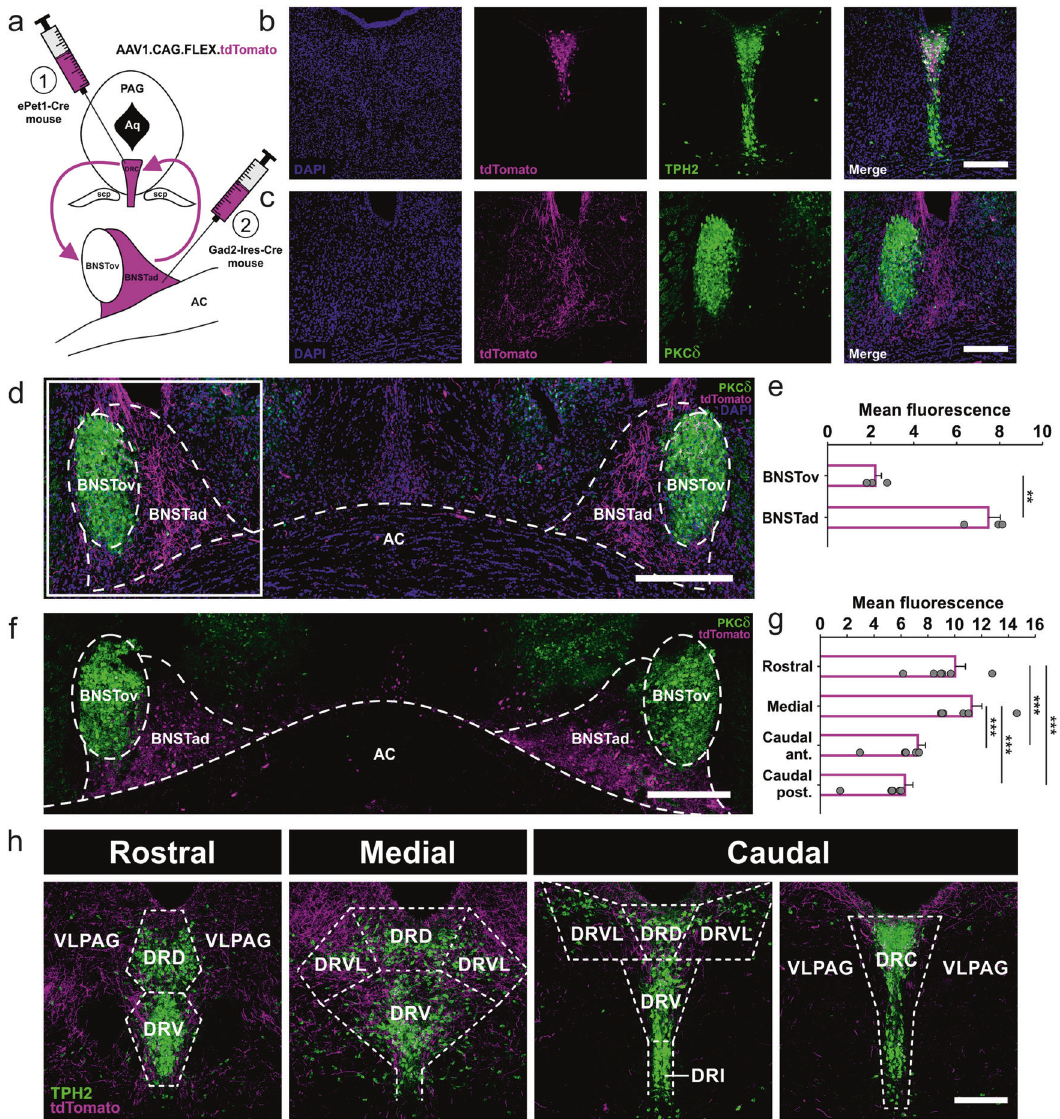
Fig. 4 The DRN and the dorsal BNST are reciprocally connected. a AAV-based labeling strategy of anterograde terminals. AAV1.CAG.FLEX.tdTomato virus was injected either into the DRC of ePet1-Cre mice (1) to label 5-HT terminals innervating the BNST, or into the BNSTad subregion of Gad2-Ires-Cre mice (2) to label GABAergic terminals innervating the DRN. b DRC injection site in an ePet1-Cre mouse indicates selective tdTomato expression (magenta) in TPH2 + 5-HT cells (green). Scale bar = 200 µm. c BNST target site in an ePet1-Cre mouse showing tdTomato + 5-HT terminals (magenta) arising from the DRC. PKC δ (green) was used as a marker for the BNSTov subregion. Scale bar = 200 µm. d Overview of the dorsal BNST in an ePet1-Cre mouse re fl ecting the bilateral innervation of the BNSTad with tdTomato + 5-HT terminals (magenta) arising from the DRC. PKC δ (green) was used as a marker for the BNSTov subregion. Boxed region is separately shown in c . Scale bar = 300 µm. e Quanti fi cation of tdTomato fl uorescence intensity in the dorsal BNST. tdTomato + 5-HT terminals innervate primarily the BNSTad subregion. Two-tailed Student ’ s paired t-test (BNSTov vs. BNSTad): P = 0.007. Injected mice ( n = 3). Data are shown as means ± SEM. ** P < 0.01. f Overview of bilateral BNSTad injection sites in a Gad2-Ires-Cre mouse. tdTomato + GABAergic cells (magenta). PKC δ (green) was used as a marker for the BNSTov subregion. Scale bar = 300 µm. g Quanti fi cation of tdTomato fl uorescence intensity in the DRN. tdTomato + GABAergic terminals arising from the BNSTad innervate all rostrocauldal DRN levels. Rostral and medial level show the strongest innervation. One-way RM ANOVA ( fl uorescence): F (3,15) = 34 . 018, P ≤ 0,001; pairwise Holm – Sidak test: rostral vs. caudal anterior: P ≤ 0.001, rostral vs. caudal posterior: P ≤ 0.001, medial vs. caudal anterior: P ≤ 0.001, medial vs. caudal posterior: P ≤ 0.001. Injected mice ( n = 6). Data are shown as means ± SEM. *** P < 0.001. h DRN target site in a Gad2-Ires-Cre mouse showing tdTomato + GABAergic terminals (magenta) arising from the BNSTad. The pattern of TPH2 + 5-HT cells (green) was used to de fi ne the respective level. Boundaries are outlined by dashed lines. DRD dorsal raphe nucleus, dorsal part; DRV dorsal raphe nucleus, ventral part; DRI dorsal raphe nucleus, interfascicular part; DRC dorsal raphe nucleus, caudal part; DRVL dorsal raphe nucleus, ventrolateral part; VLPAG ventrolateral periaqueductal gray. Scale bar = 250 levels on the rostrocaudal extend (rostral, medial, caudal), each main source of serotonergic forebrain innervation [46]. The DRN encompassing several subregions (see Fig. 2a). Only the caudal accounts for the largest number of serotonergic neurons and is DRN level contained two distinct portions. Besides the exclusive generally considered to play an important role in the processing of analysis of cFos positive (cFos + ) cells, we analyzed cFos anxiety and fear [1, 47, 48]. As 5-HT neurons are topographically colocalization with tryptophan hydroxylase 2 positive (TPH2 + ) organized in the DRN [37], our analysis included three distinct